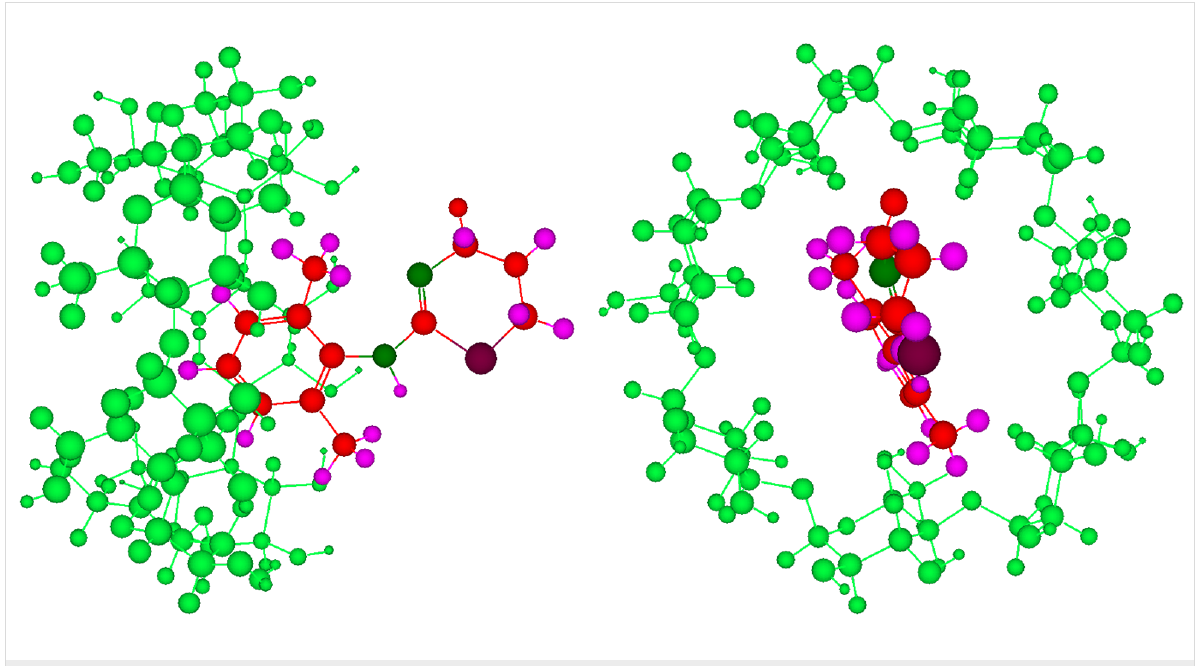
Figure 10: Side and front views of the proposed conformation of the β -CD-xylazine complex.